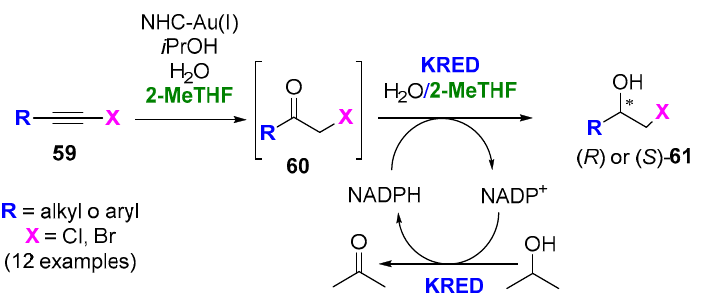
Figure 31. Chemoenzymatic cascade for producing enantiopure halohydrin from haloalkynes in aqueous/2-MeTHF medium.